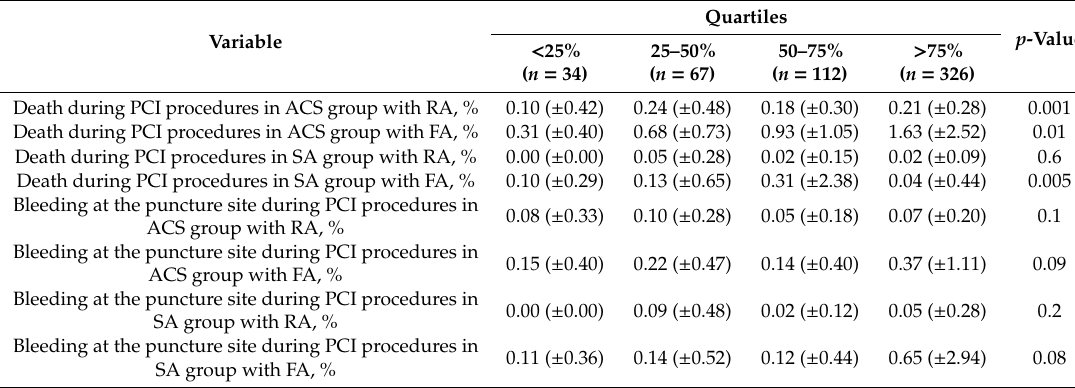
Table 6. Clinical outcomes of percutaneous coronary intervention performed by operators divided into quartiles depending on operator’s utilization of radial access site. Data presented separately for stable angina and acute coronary syndrome.